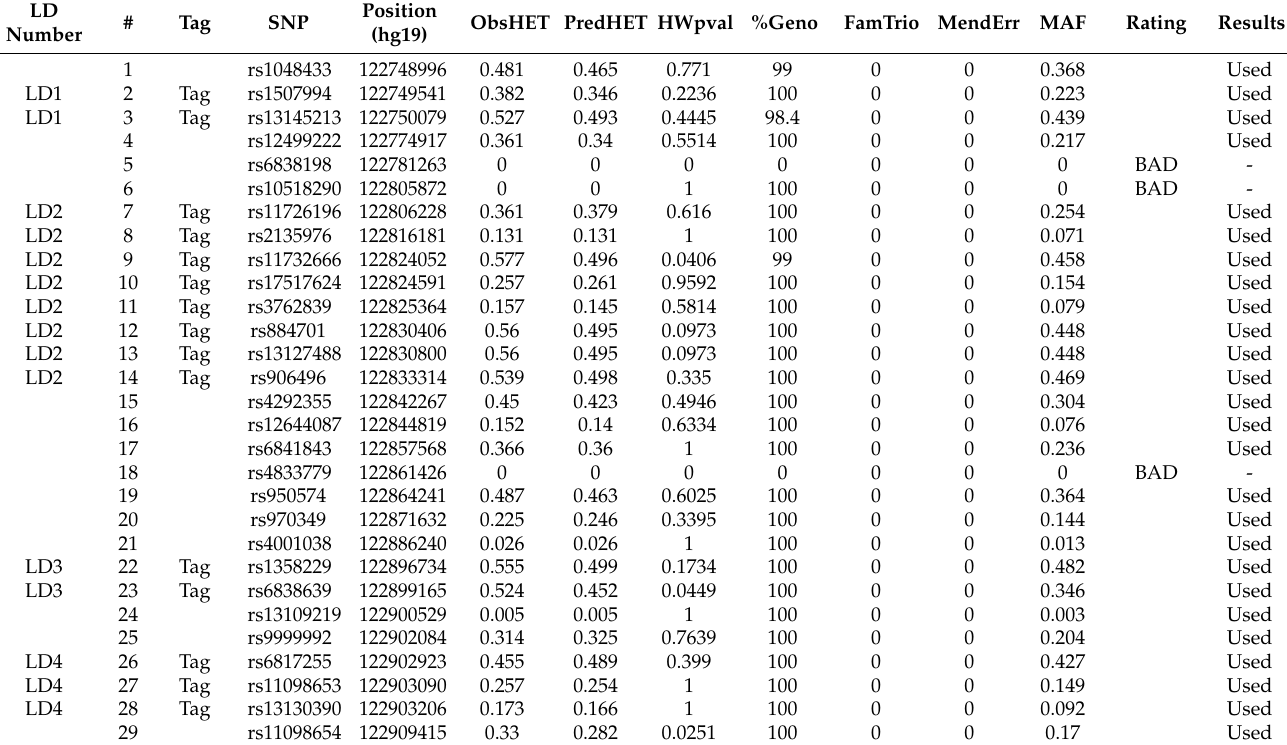
# Matches the number in Figure 1. Tag SNPs are indicated with a circle. MAF, minor allele frequency (those with a value of 0 were excluded [=BAD], and finally 26 [=Used] in the results column were used); ObsHET, observed heterozygosity p value; PredHET, predicted heterozygosity p value; HWpval, Hardy–Weinberg equilibrium p value; %Geno, percentage of the non-missing genotypes for this marker; FamTrio, number of fully genotyped family trios for this marker (0 for datasets with unrelated individuals); MendErr, number of the observed Mendelian inheritance errors (0 for datasets with unrelated individuals).